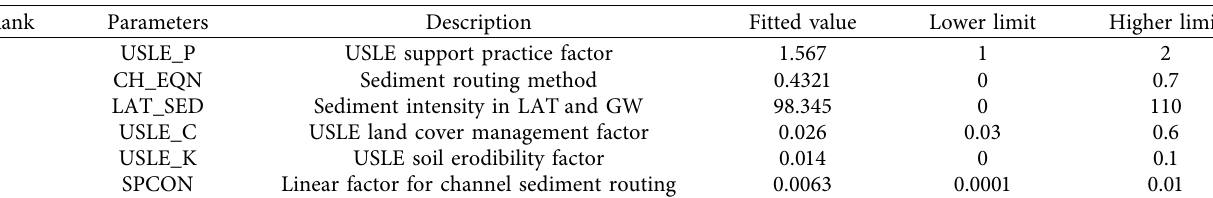
Table 7: Sediment calibration parameters and their sensitivity